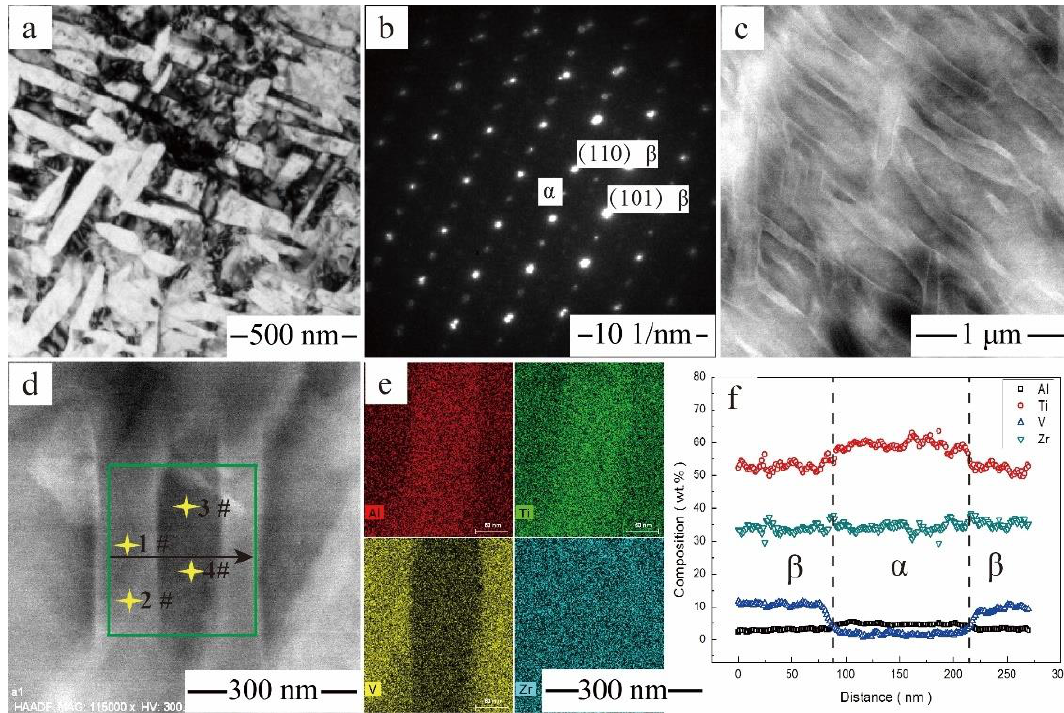
Figure 12. Microstructural feature of the Ti6Al4V30Zr alloy after aging at 650 °C: ( a ) BF image; ( b ) SAD pattern with [111] β zone axis; ( c , d ) HAADF-STEM images showing α phase; ( e ) the EDS mapping of Zr, V, Al, and Ti atoms; ( f ) the composition profiles along the arrows shown in ( d ).